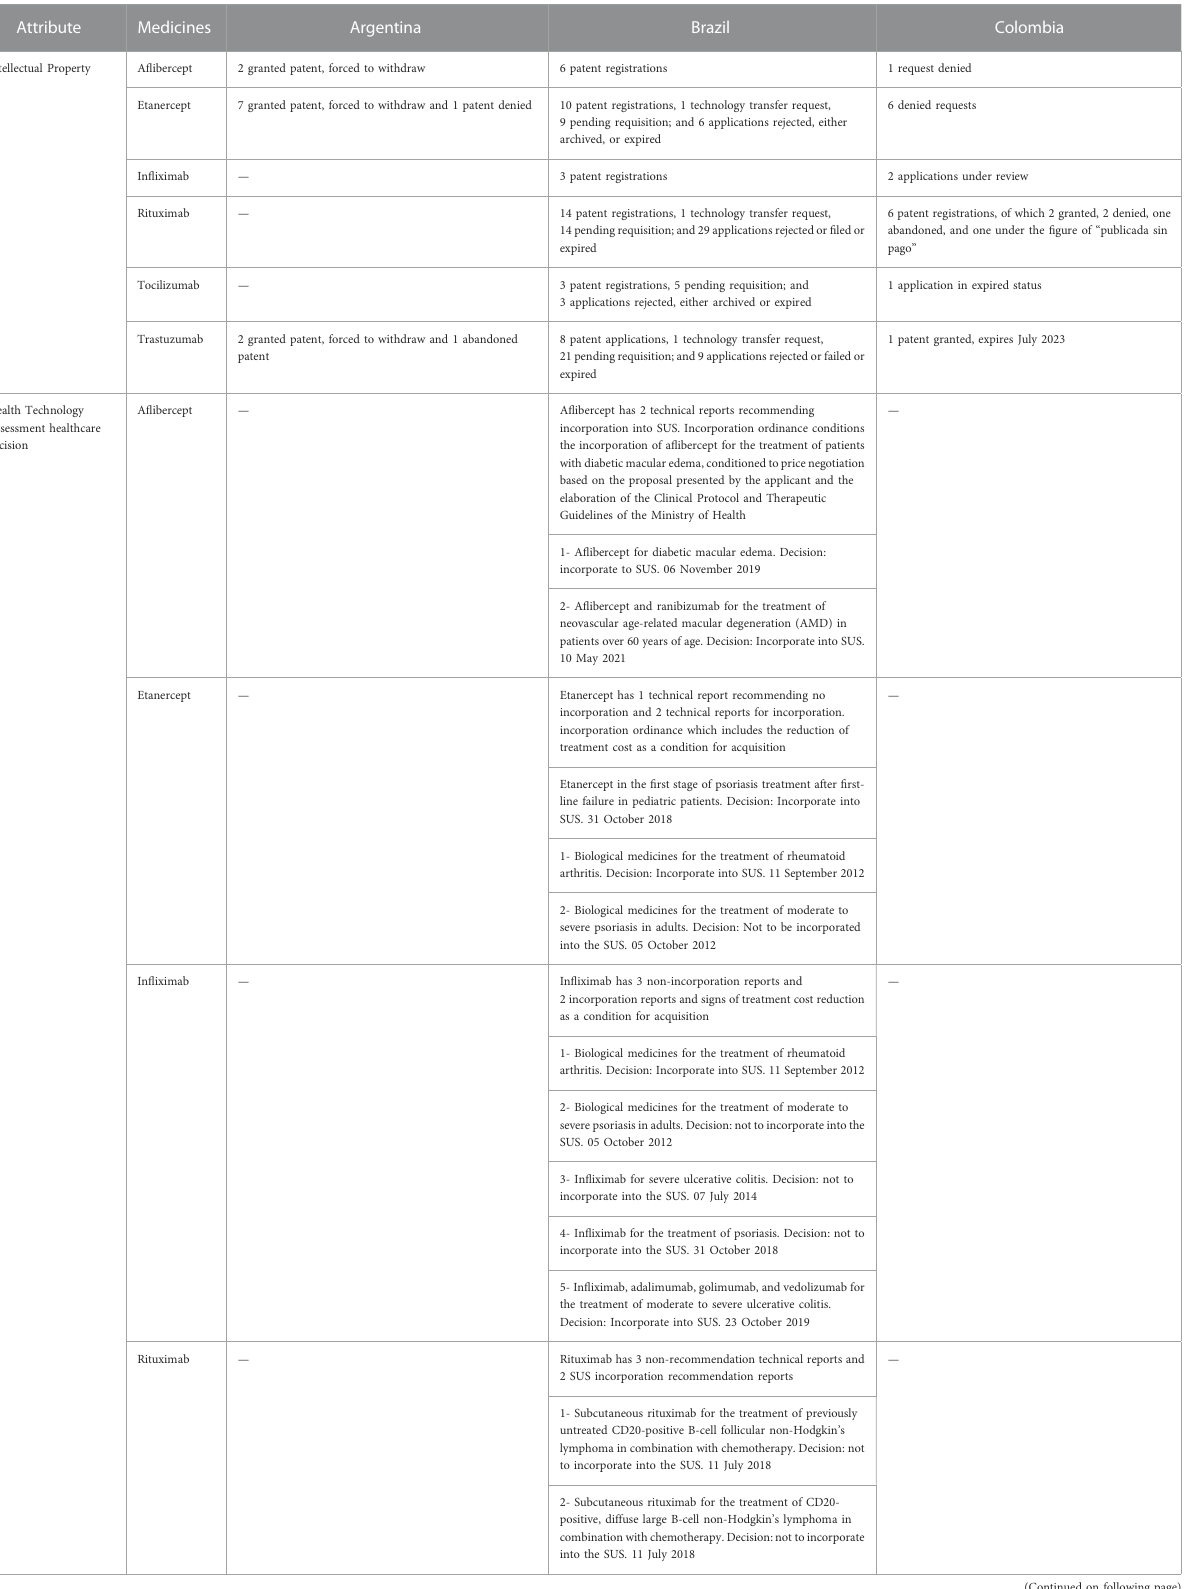
TABLE 3 Intellectual Property and Health Technology Assessment health care